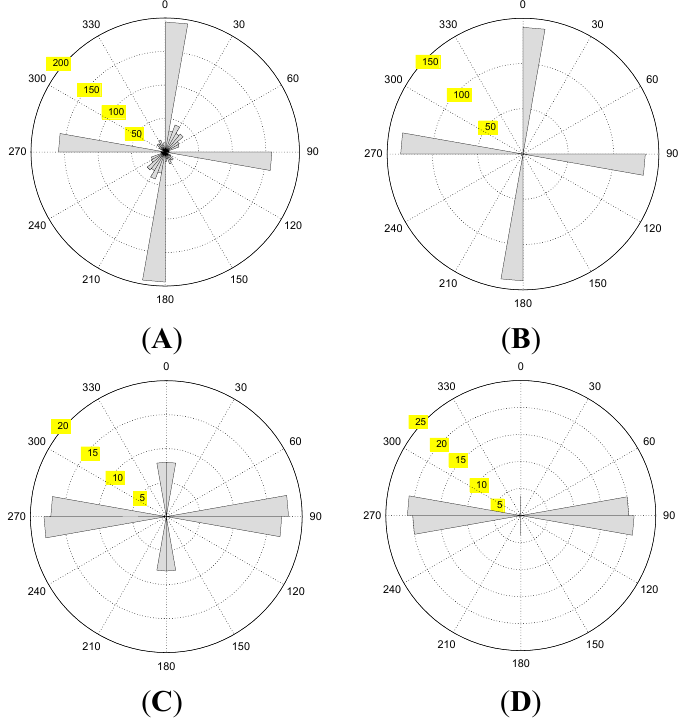
Figure 10. ( A – C ) : Rose diagrams for discontinuities extracted by Hough transform, Tavares-Padilha algorithm and B-spline method, respectively. ( D ): Rose diagram for reference lineament